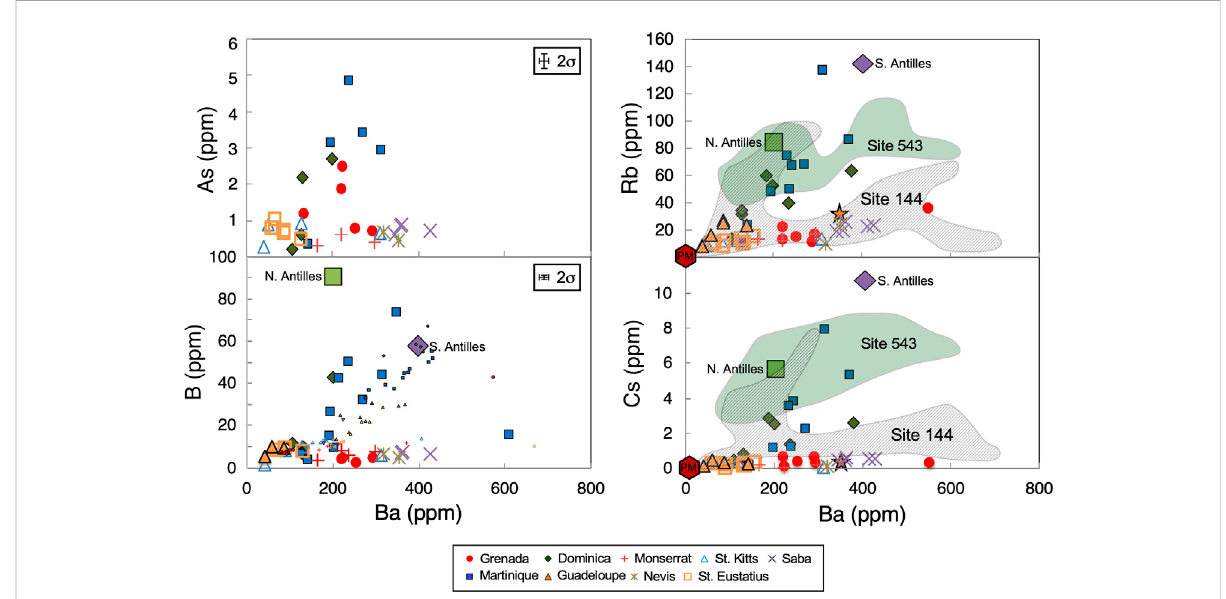
FIGURE 7 Fluidmobileelements(B,As,CsandRb)plottedagainstBarium.EnrichmentsinFMEareobviousforMartiniqueandDominicaandareconsistent among all FME. Grenada shows low B, Cs and Rb but anomalously higher As, whereas lavas from the northern LAIA are all depleted in FME but enrichedinBarium.FieldsshownforCsandRbplotsareforindividualSite543(greenshading)andSite144analysis(hatched)compiledbyCarpentier (2007).InterestinglySite144sedimentsalsohaveadivergingsplitbetweenhighBalowCsandRbandhigherCsandRbcompositions.Errorbars for the FME (2 σ ) are shown where variation is large enough to display, but Ba errors are consistent throughout plots.